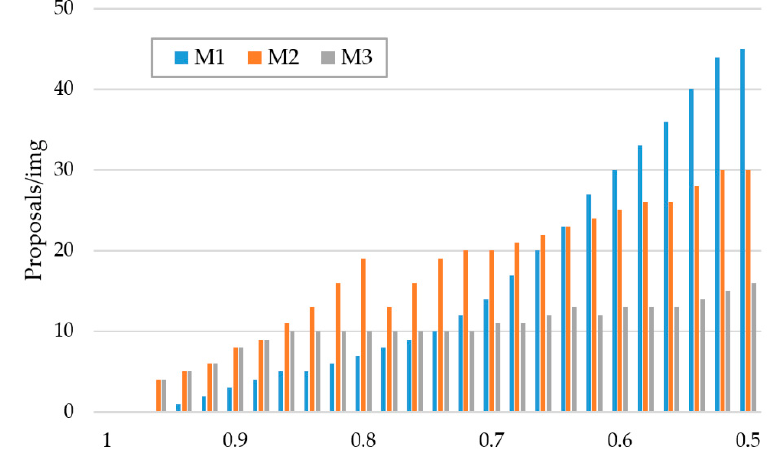
Figure 8. The IoU distribution of the M1, M2 and M3 proposals.